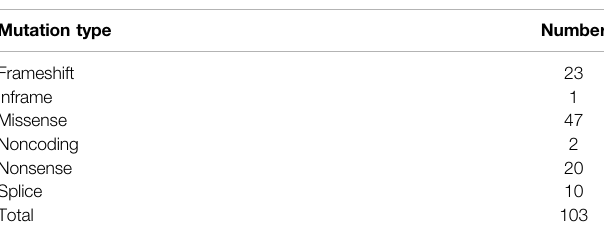
TABLE 2 | CHD2 mutations reported